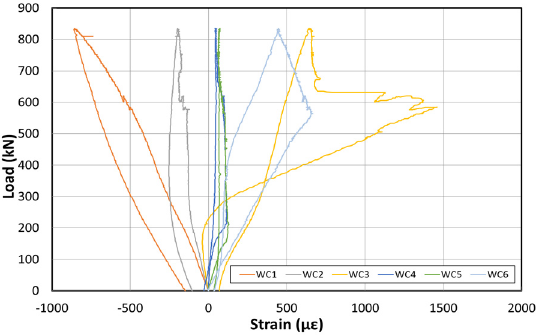
Figure 20. Concrete strain curves at the center after reinforcement based on the NSM method.